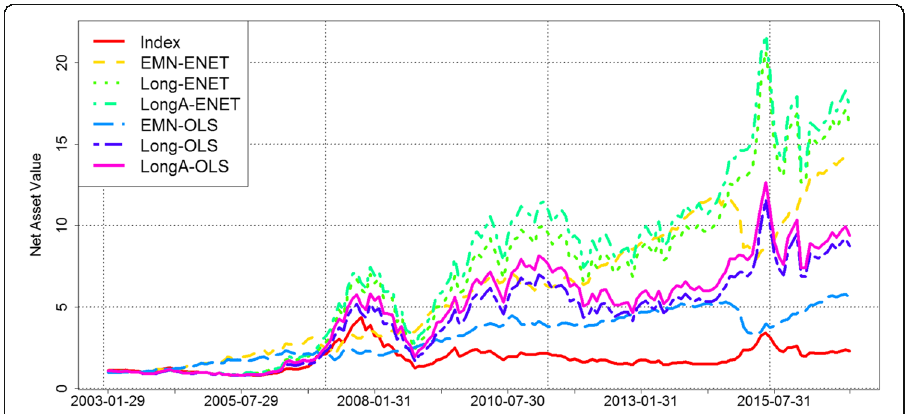
at which the time series lines last touch the 0-reference line (the gray-dashed line at the top) is the time when each portfolio reaches its historical highest cumulative